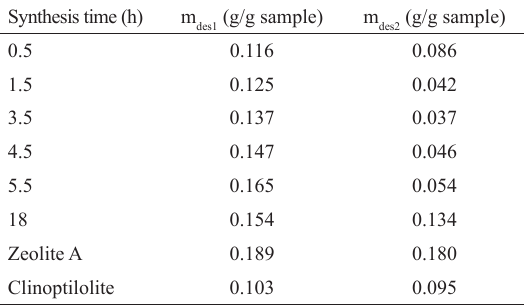
Figure 4: XRD pattern of the powder material formed in the reaction mixture with composition C after 4.5 h of conventional primary synthesis at 90°C. Table 3: Desorption capacities of powder samples obtained from composition C at 90 0 C by conventional synthesis and the primary capacities of commercial zeolite A and clinoptilolite powder. m des1 and m denote the first and second TG measurements performed des2 for each sample.